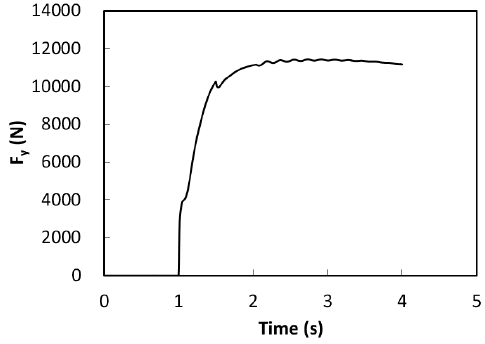
Figure 22. Total lateral force with middle level control.